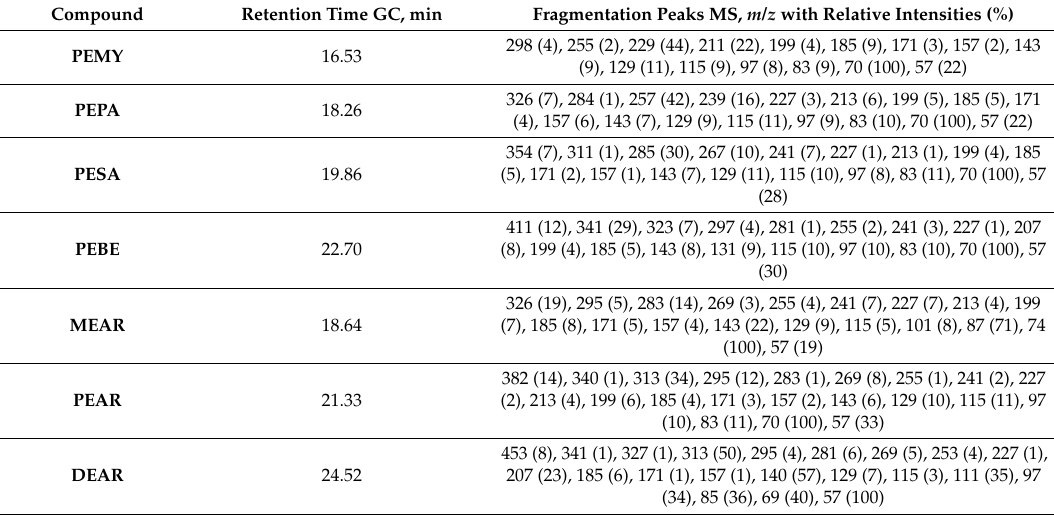
Table 1. Retention times in min derived from the gas chromatography (GC) chromatograms measured and fragmentation patterns reported from mass spectroscopy (MS) spectra with relative intensities in brackets. The most abundant fragment is assigned a value of 100% while all other fragments’ intensities are calculated as a relative percentage of the main fragment.